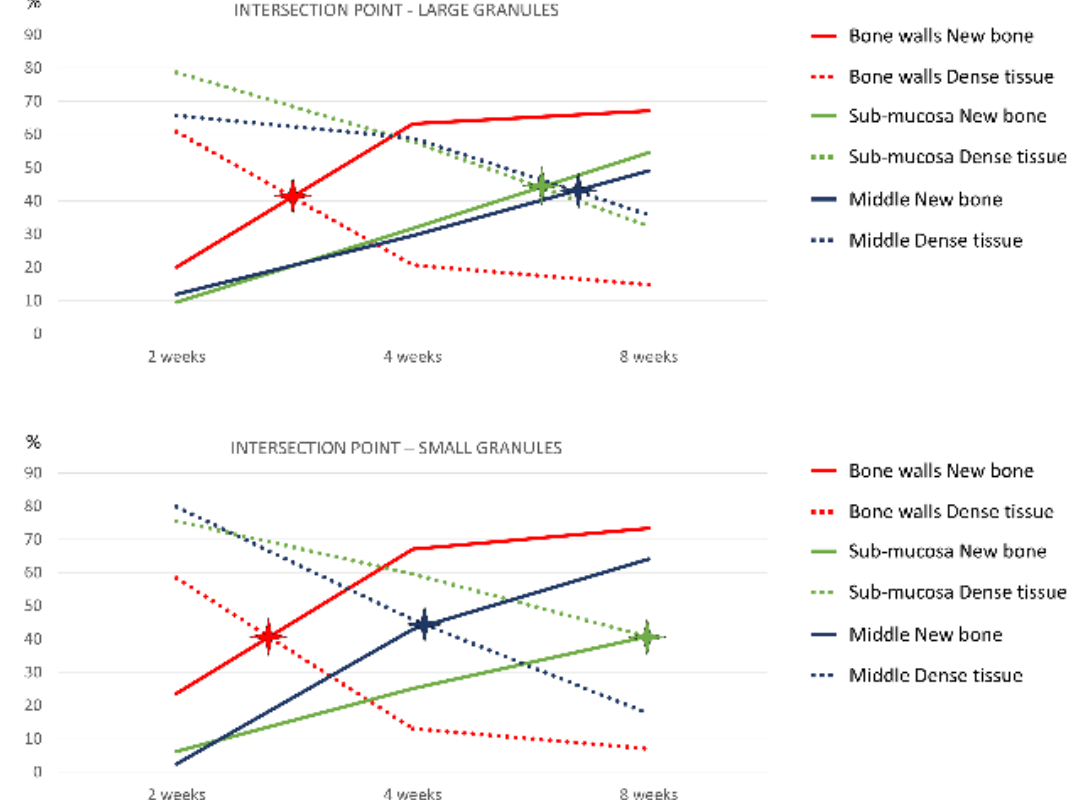
Figure 7. Photomicrographs of ground sections representing the healing after 8 weeks at small granule sites. ( A ) Marrow spaces were seen at this stage of healing (yellow asterisks). ( B ) A particle with augmented chromaticity, not yet reached by newly formed bone. Original magnification ×200. Stevenel’s blue and alizarin red stain.